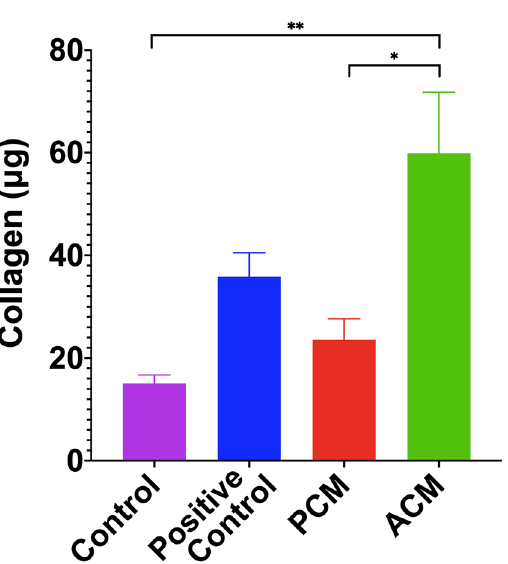
Figure 3. Adipocyte Conditioned Medium Converts Fibroblasts to Myofibroblasts. Representative images showing the extent of α -SMA labeling (red) after 48 hours of exposure to control medium (control), TGF- β 1 and AA (positive control), pre-adipocyte conditioned media (PCM), or adipocyte conditioned media (PCM). Cell nuclei labeled with are shown in blue. One-way ANOVA with Tukey post hoc tests ( *** p < 0.001) indicate that the percentage of α -SMA positive cells was significantly higher for positive control and ACM compared to control and PCM (mean ± SD, n = 3).